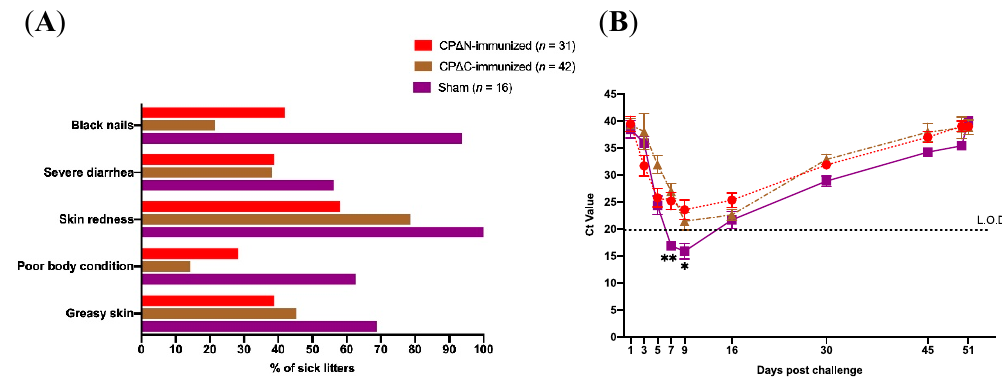
Figure 6. Graphs of the results of the real-time polymerase chain reaction (PCR) and clinical signs observed in the experiment of litter minks. After birth, the one-day newborn litters ( n = 89) of immunized and sham adult moms ( n = 17) were challenged with 10 7 /mL MAstV copies. As a follow-up, the fecal samples ( n = 414) of their newborn litters on test days 1, 3, 5, 7, 9, 16, 30, 45, 50, and 51 post-challenge were tested using a real-time PCR for detecting AstV shedding status. The clinical signs of litters were also monitored and recorded by the author veterinarians every other day. ( A ) The ratios of litters showing various clinical signs to total group-related litters were calculated and illustrated as a percentage (%) in the graph. ( B ) The mean cycle threshold (Ct) value of real-time PCR results of sampled litters on each sampling occasion during challenge experiment (51 days) was calculated and is illustrated in the graph. Asterisks show a significant decline of virus shedding among litters of either both CP ∆ N- and CP ∆ C- (**) or just CP ∆ N- (*) immunized adult mom groups compared to those of the sham group using the Log-rank test ( p < 0.05). Bars indicate the standard deviation (SD). Table 2. Summarizing the evaluated clinical sign observation of litters in mink trial. Group of Experiment No. of Sham 1